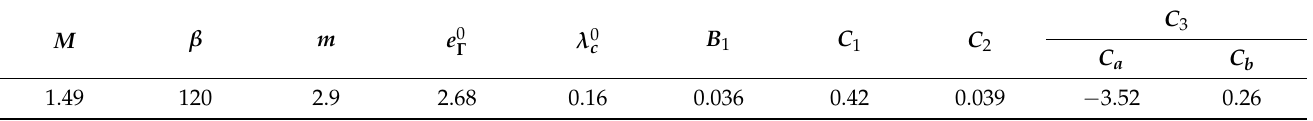
Table 4. Parameters for prediction of calcareous sand under breakage and cementation failure.